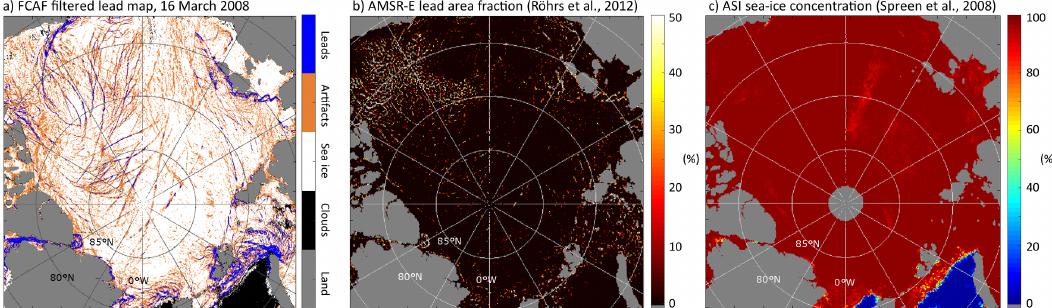
Figure 7. ( a ) FCAF filtered daily lead map for 16 March 2008 (compare Figure 1d); ( b ) AMSR-E lead area fraction ([26]), acquired from Integrated Climate Date Center (ICDC, http://icdc.zmaw.de/), University of Hamburg, Germany; ( c ) ASI sea-ice concentration ([42]), data from the Institute for Environmental Physics, University of Bremen (http://www.iup.uni-bremen.de), Germany. Data in (b) and (c) were projected to the pan-Arctic grid used for (a), keeping their original